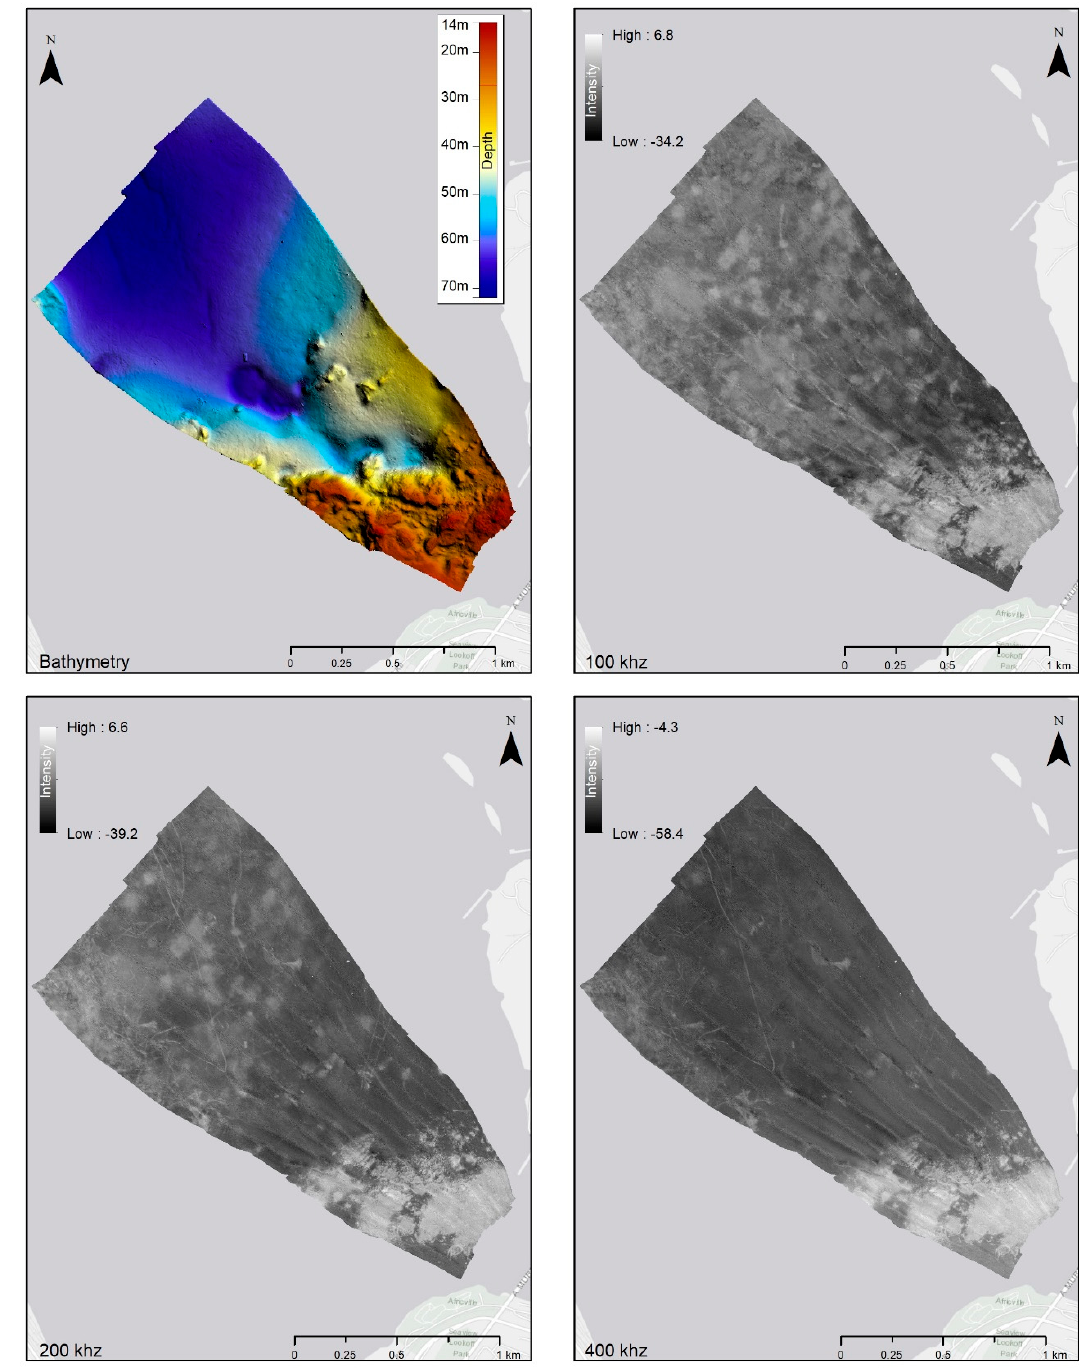
Figure 5. 2017 MBES bathymetry and multispectral backscatter: 100 kHz, 200 kHz, and 400 kHz mosaics.